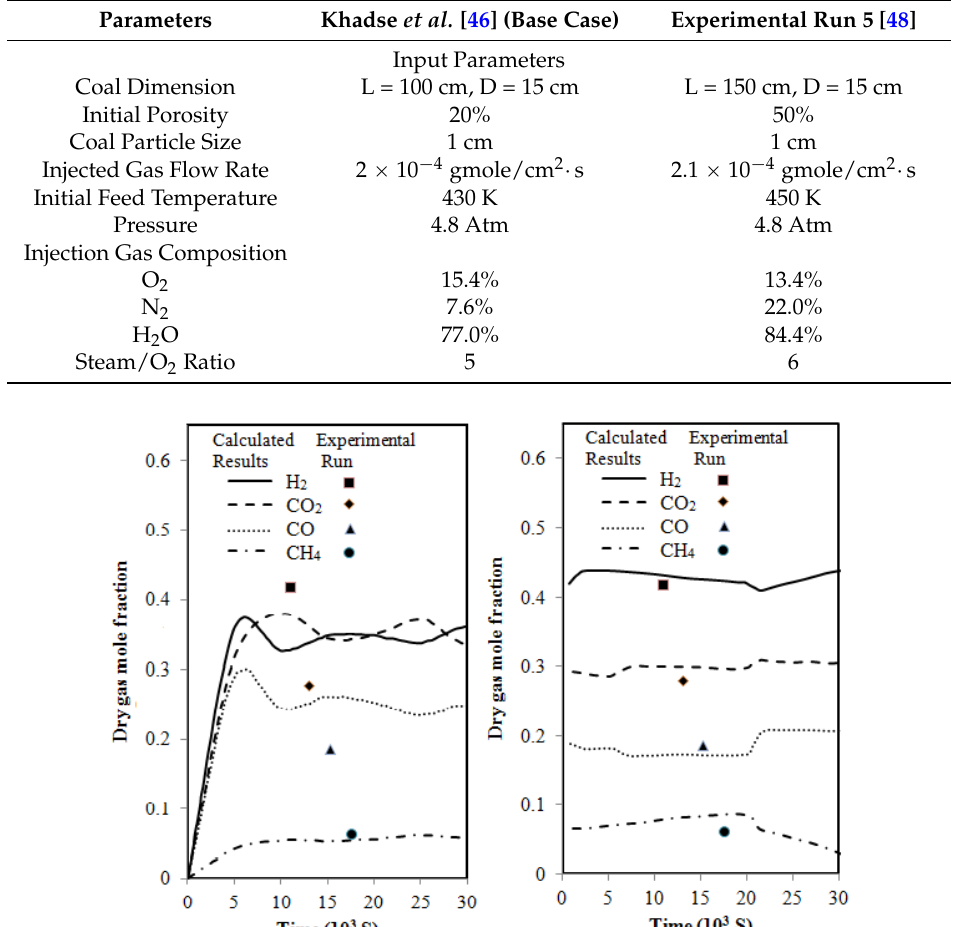
Figure 8. Comparison of calculated exhaust gas compositions with experimental results from Thorsness et al. [48]; ( a ) Khadse et al. [46]; ( b ) Thorsness et al. [48]).